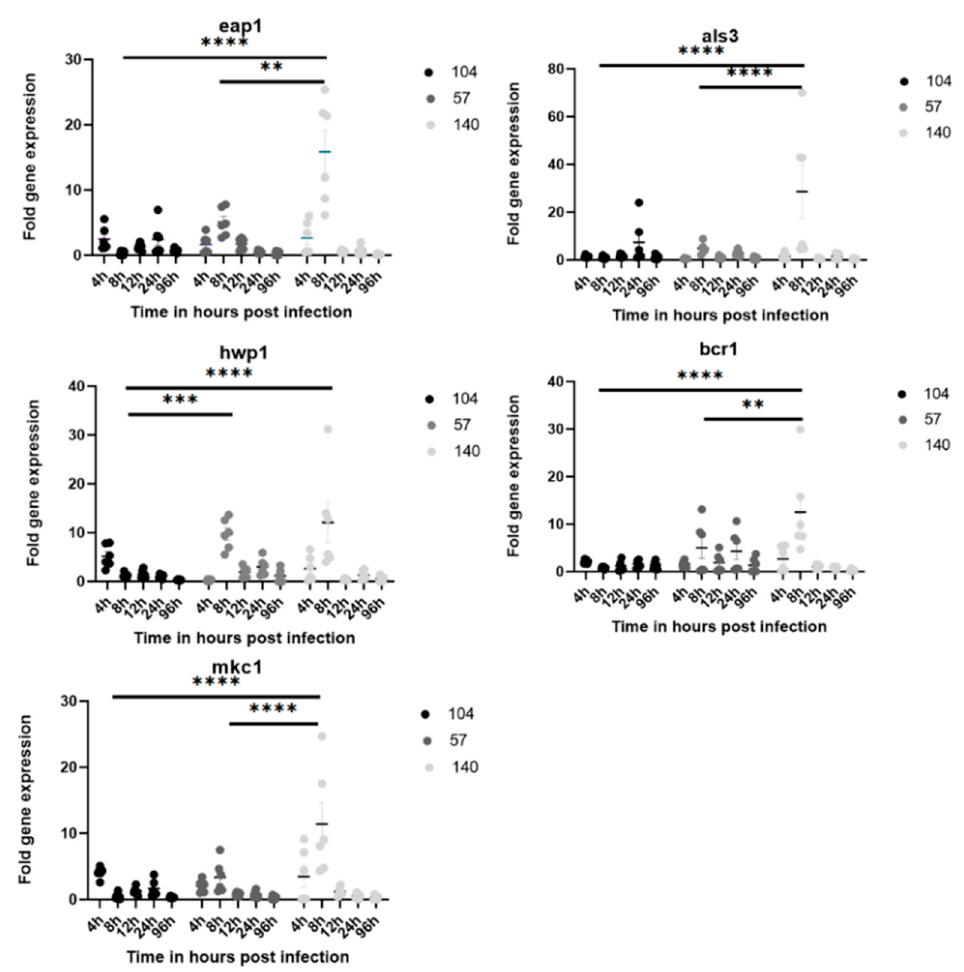
Figure 3. The expression levels of eap1 , als3 , hwp1 , bcr1 , and mkc1 in C. albicans strains 104, 57, and 140 infected zebrafish larvae, by time point. Each experimental group of 30 zebrafish was injected with 0.7 OD yeast cells of one of the C. albicans strains. The normalized ratios of expression were calculated by comparison with the level of expression of the act-1 gene in each group of planktonic cells. Each experiment was performed in duplicate. h, hour; **, p < 0.01; ***, p < 0.001; and ****, p < 0.0001.